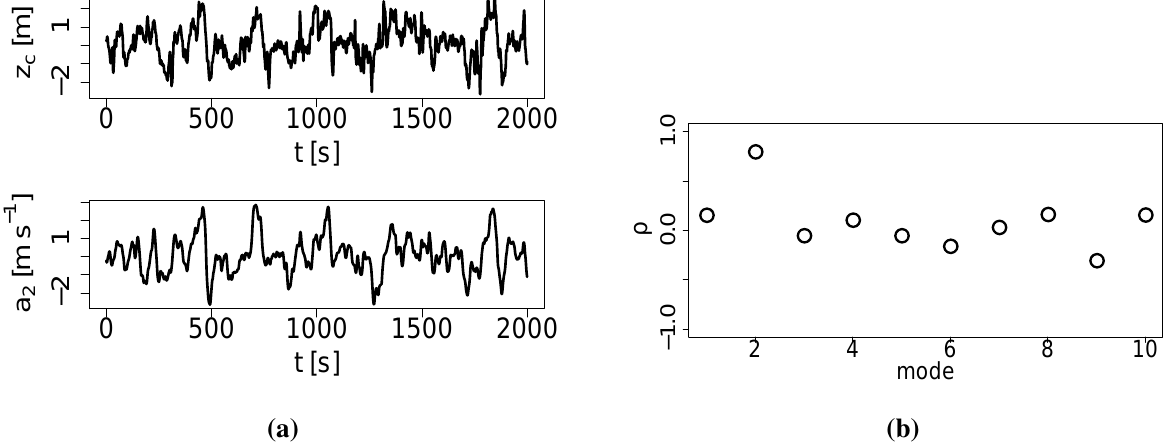
Figure 13. ( a ) Time series of the second weighting coefficient a of the deficit z ; ( b ) correlation coefficients ρ of the horizontal deficit position z c weighting coefficients of the first 10 modes.